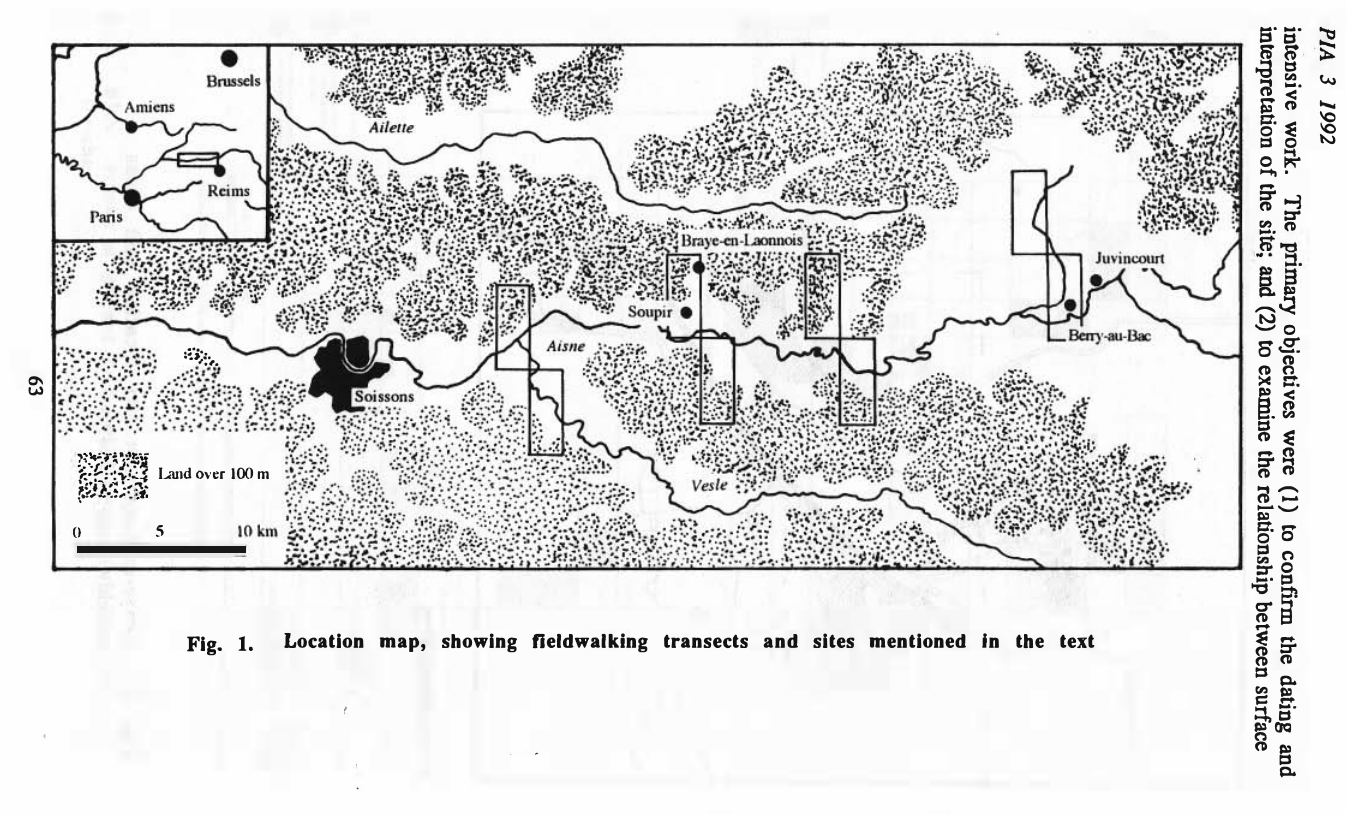
Fig. 1. Location map, showing fieldwalklng transects and sites mentioned In the